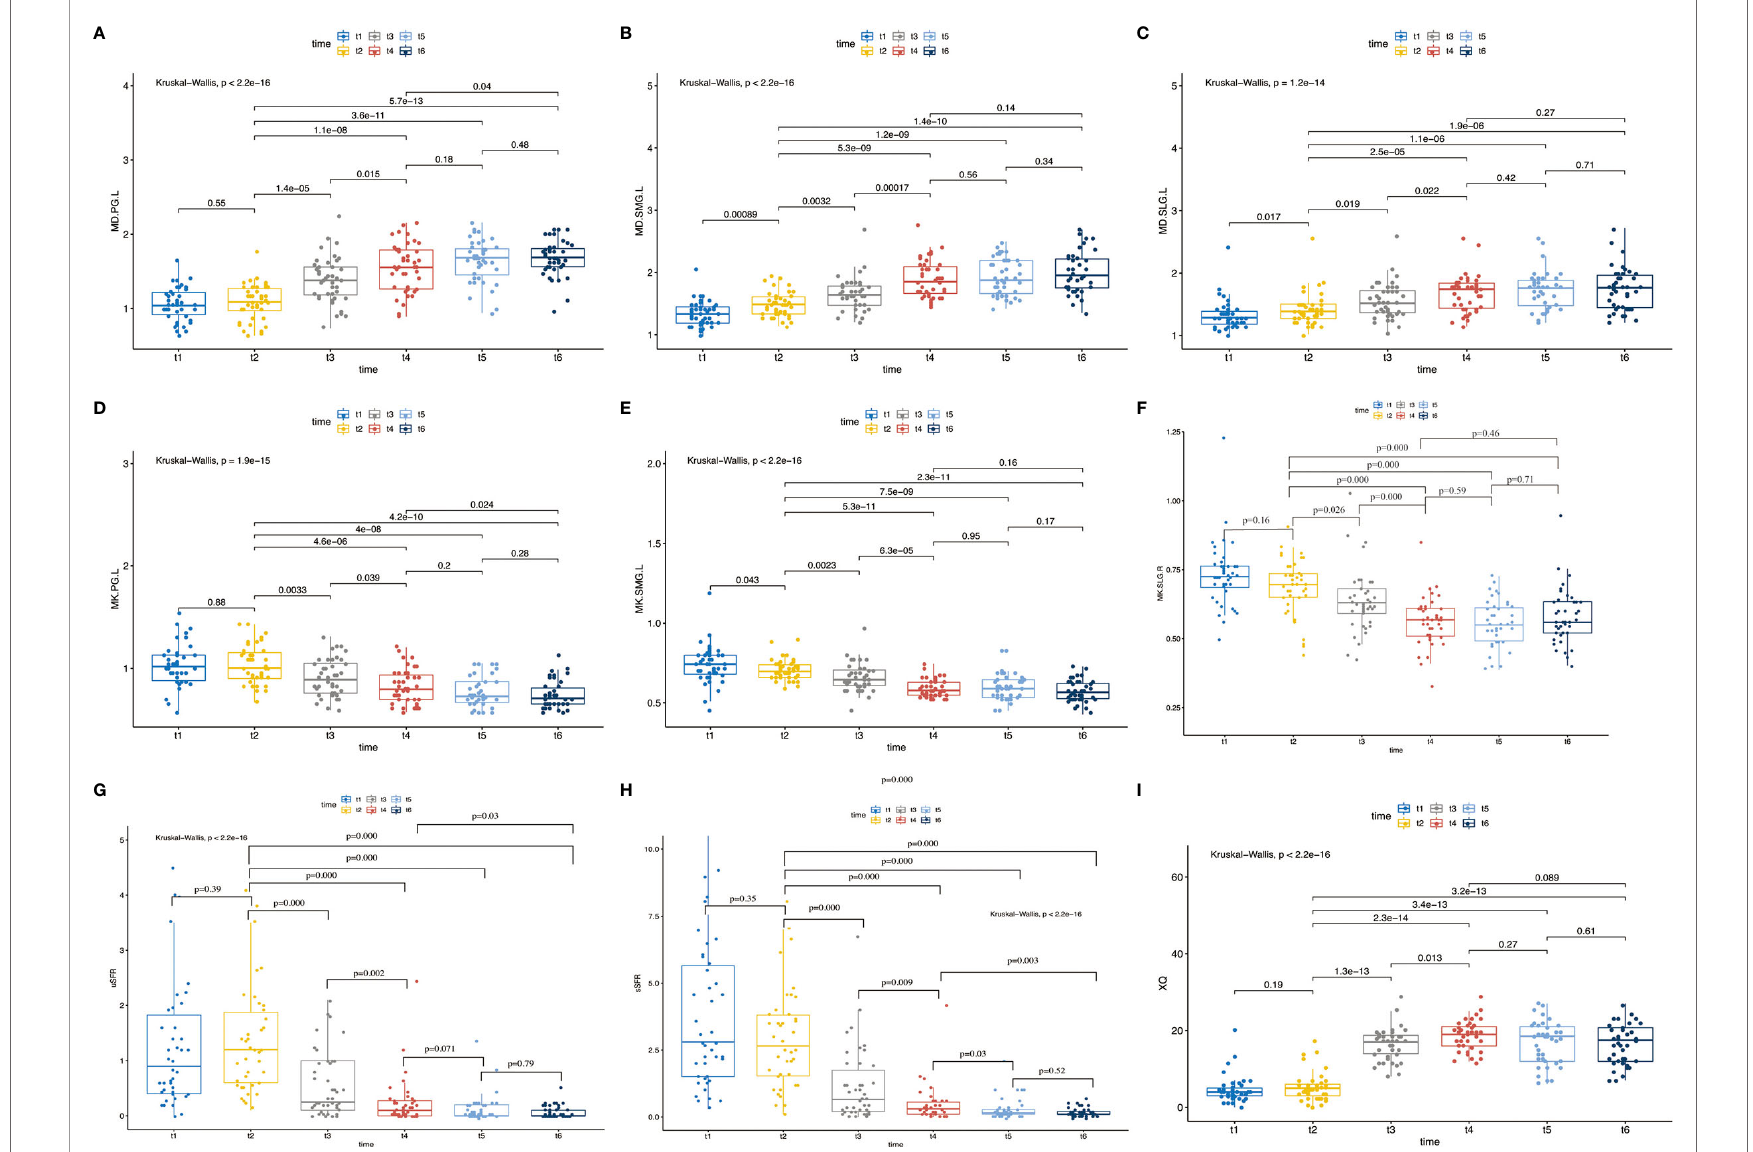
FIGURE 4 | (A – I) The pairwise comparisons of MD and MK of left PG, SMG, SLG, and uSFR, sSFR, and XQ between different time points; p < 0.05 denotes signi fi cant differences between two time points linked together. Abbreviations are referred to in Table 2